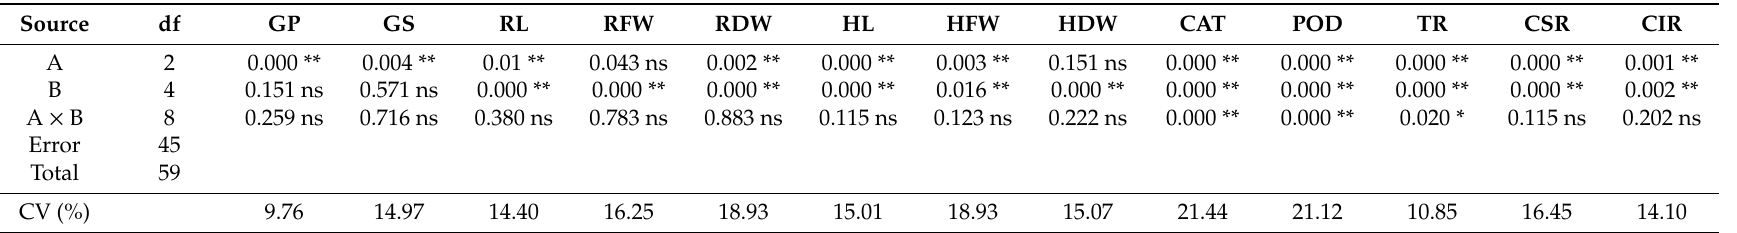
Table 1. Analysis of variance for germination percentage (GP), germination speed (GS), root length (RL), root fresh weight (RFW), root dry weight (RDW),